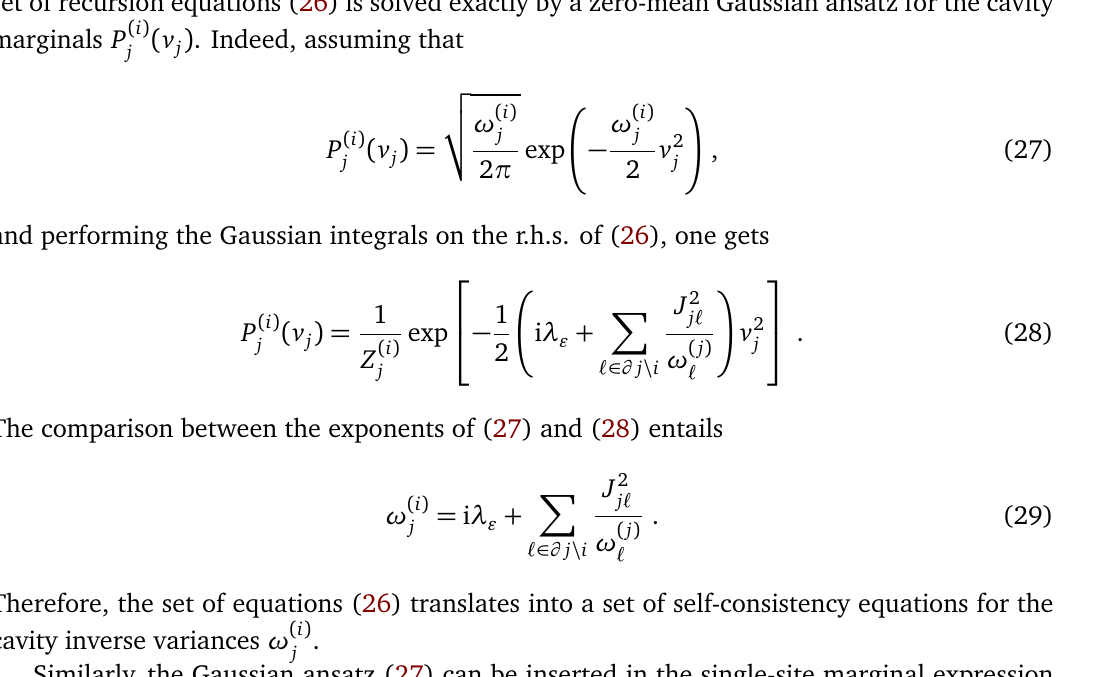
, j and j , neighbours of the 1 2 3